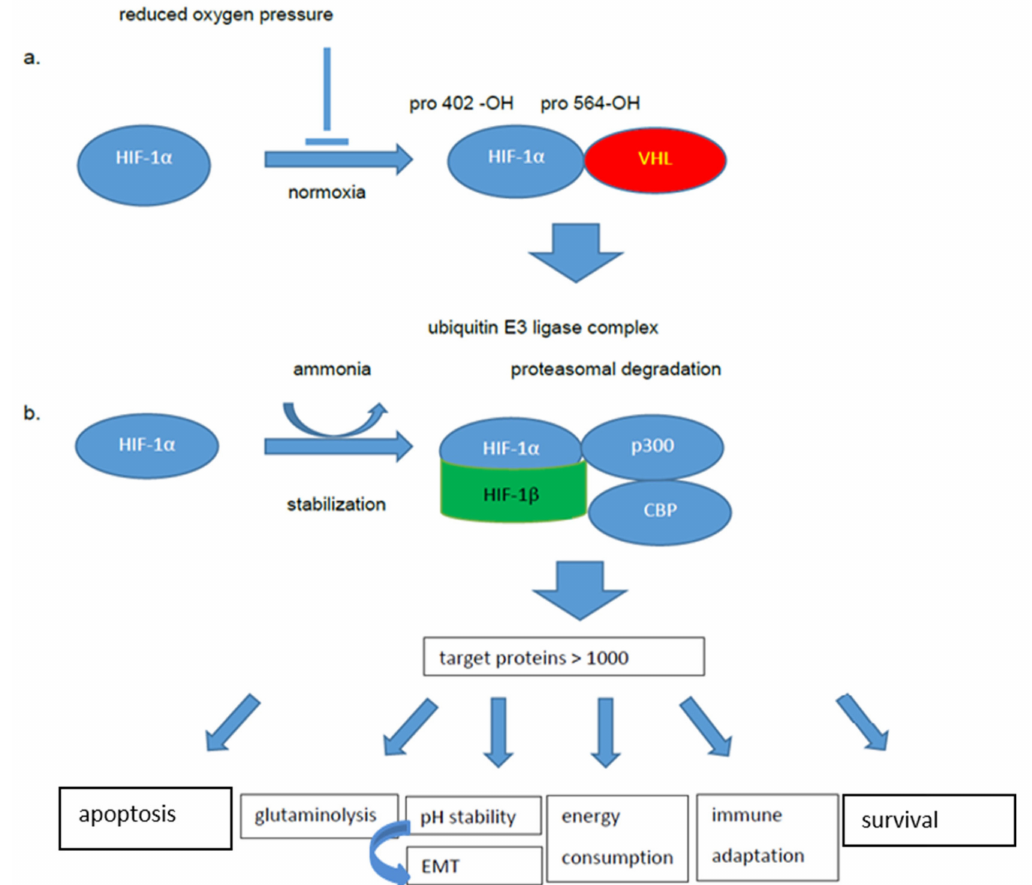
Figure 1. Role of HIF-1 α in oral carcinogenesis. ( a ). Classical normoxic condition. Hydroxylation at proline residues 402 and 564, dimerization with the VHL protein and proteasomal degradation due to a ubiquitin E3 ligase complex. ( b ). Hypoxia of oral cancer and “tumor normoxia”, ammonia and / or low pH levels prevent the proline hydroxylation and can cause the stabilization of HIF-1 α , its transport to the nucleus, dimerization with HIF-1 β , which in combination with the p300 protein and CBP complex results in the regulation of more than 1000 target